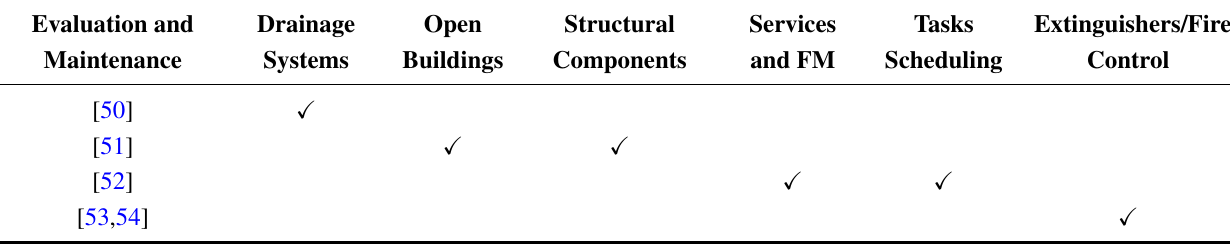
Table 7. Works focused on the evaluation and maintenance of